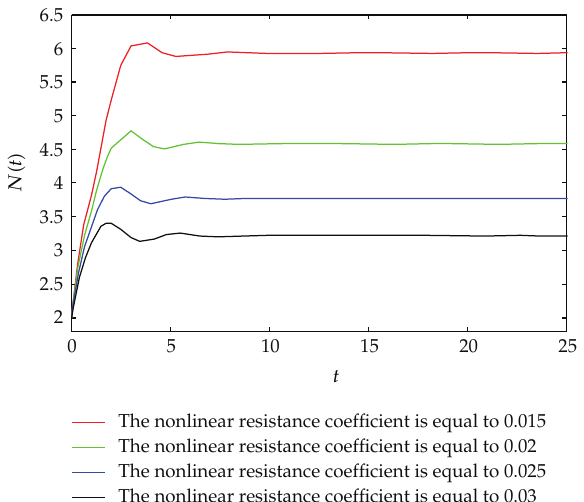
Figure 5: The step response of the process of credit risk contagion where 𝜆 = 0.1